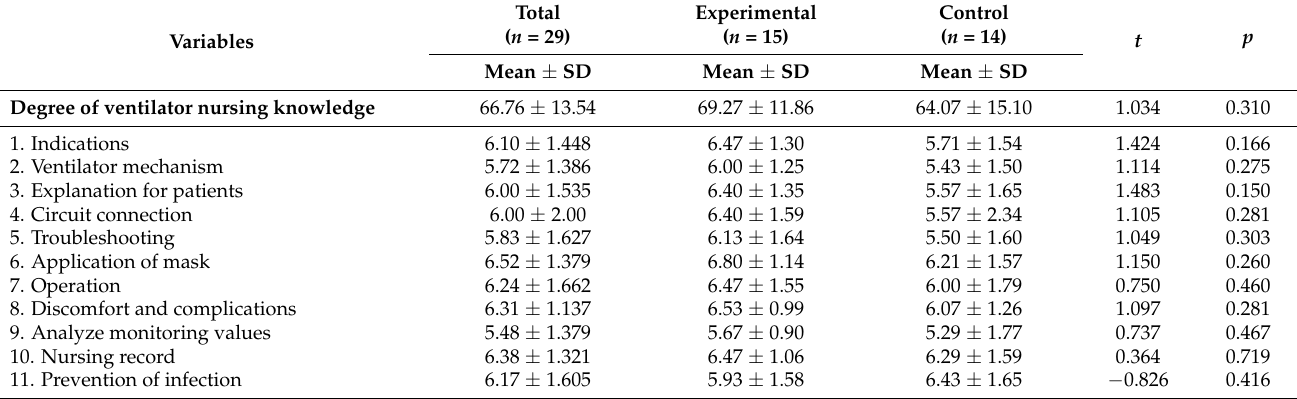
Table 2. Participants’ analysis of